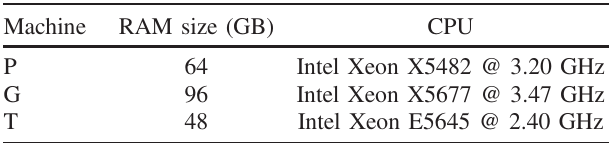
TABLE III. Configuration of computers used to determine the scattering spectra of CSC